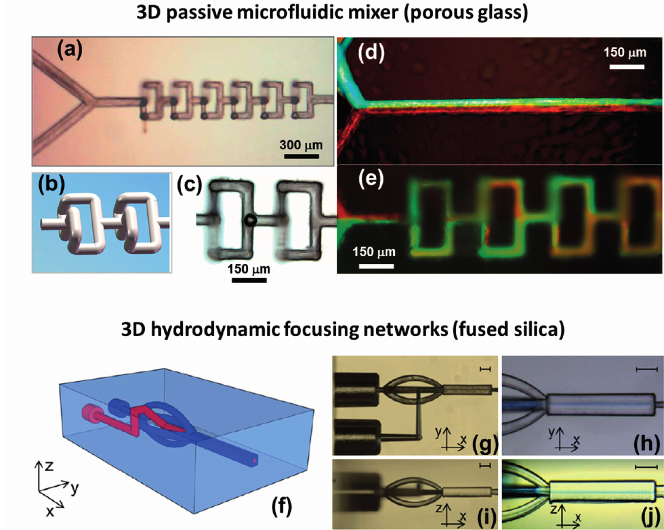
Figure 11. Fabrication of a 3D passive microfluidic mixer in porous glass, and 3D hydrodynamic networks in fused silica using FsLDW, respectively. ( a ) Optical micrograph of microfluidic mixer; ( b ) Schematic illustration of two mixing units; ( c ) Top-view optical micrograph of two mixing units. Fluorescence microscopy images of ( d ) 1D and ( e ) 3D microfluidic mixing experiments (Reproduced with permission from RSC. © 2012 by the Royal Society of Chemistry); ( f ) Schematic illustration of 3D hydrodynamic focusing network [95]; ( g ) Top-view and ( i ) side-view optical micrographs of fabricated device; ( h ) Top-view and ( j ) side-view optical micrographs of flow confinement in the horizontal and vertical directions achieved with a sample/sheath pressure ratio of 0.55. The scale bars in ( g – j ) represent 100 µm [120]. (Reproduced with permission from RSC. © 2014 by the Royal Society of